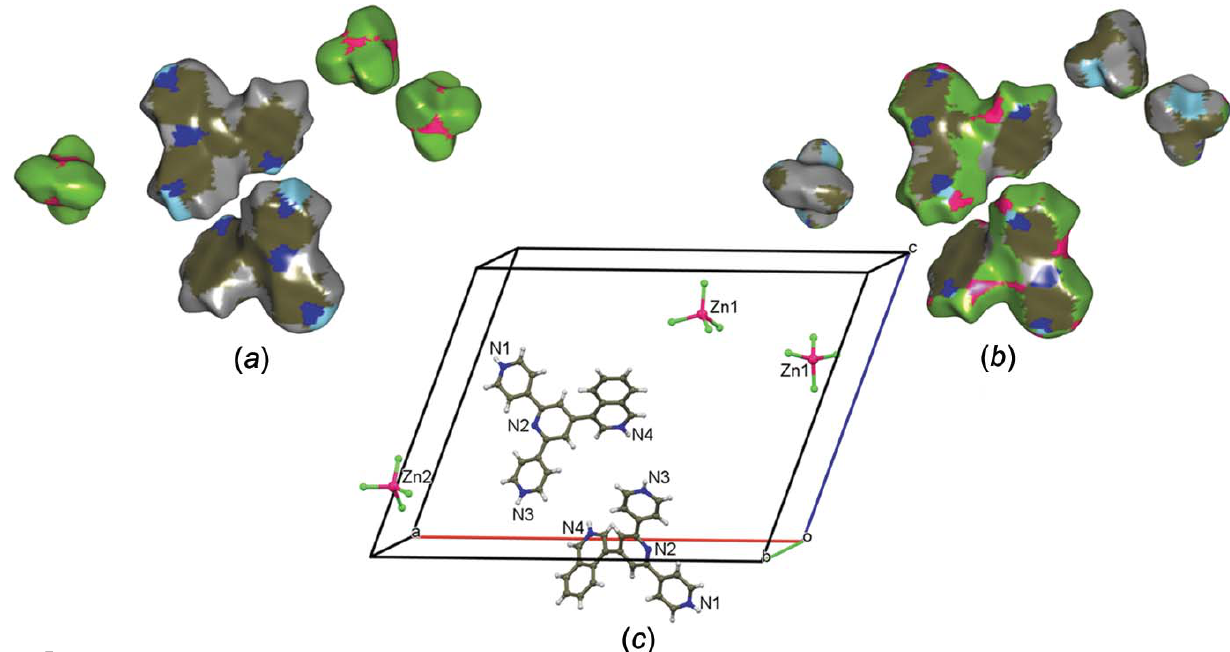
Figure 5 Right and left: Hirshfeld surfaces of the independent entities of (I) shown in ( c ) (conveniently set apart as to avoid overlapping) and colored in accordance with the species contributing most to the electron density on the surface; ( a ) surfaces coloured according to the interior atoms ( b ) surfaces coloured according to the exterior atoms. Colour key: H C : grey, H N : light blue, C: dark brown, N: blue, Cl: green, Zn: purple.